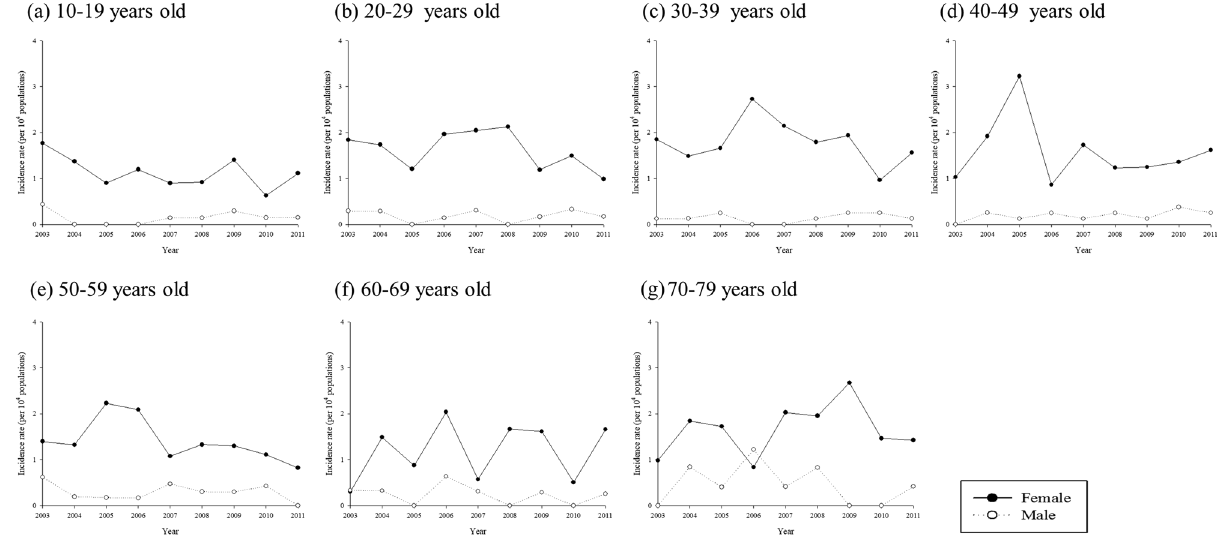
Figure 3. Incidence rate of SLE from 2001 to 2011 by age groups. All Female Male RR (95% C.I.) p value RR (95% C.I.) p value RR (95%